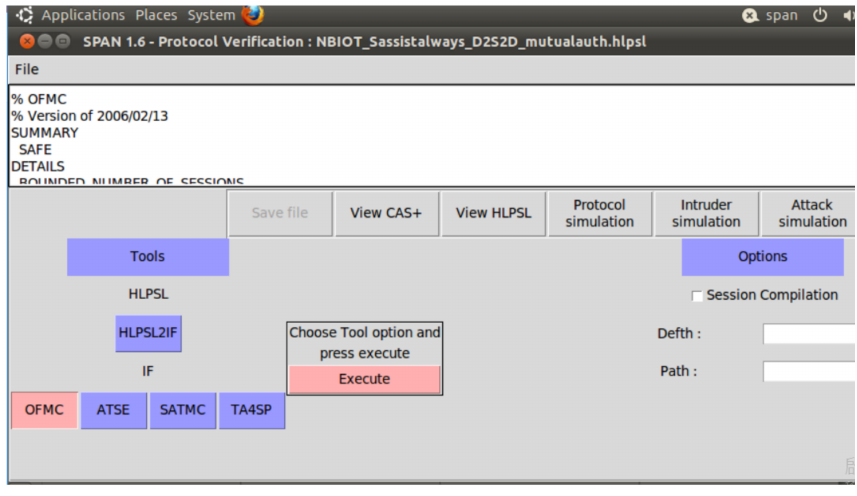
Figure 12. OFMC checks the security of the S-assist-always D2S2D